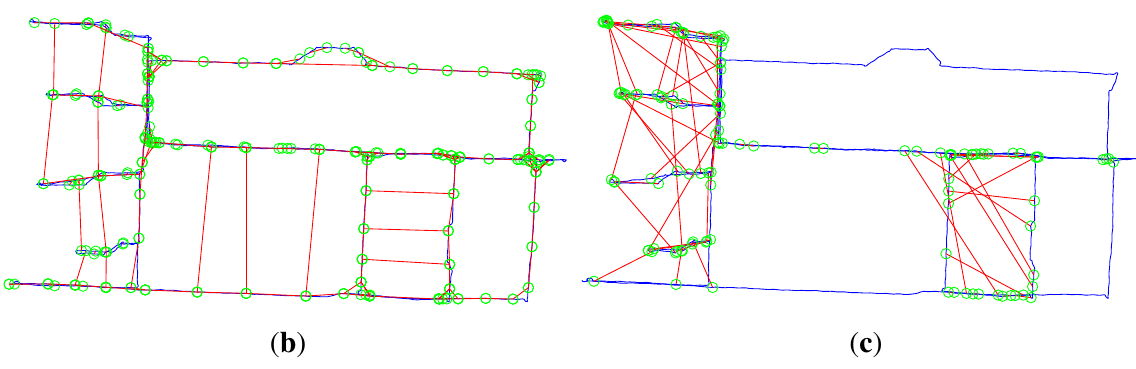
Loop Closure Locations − Manual